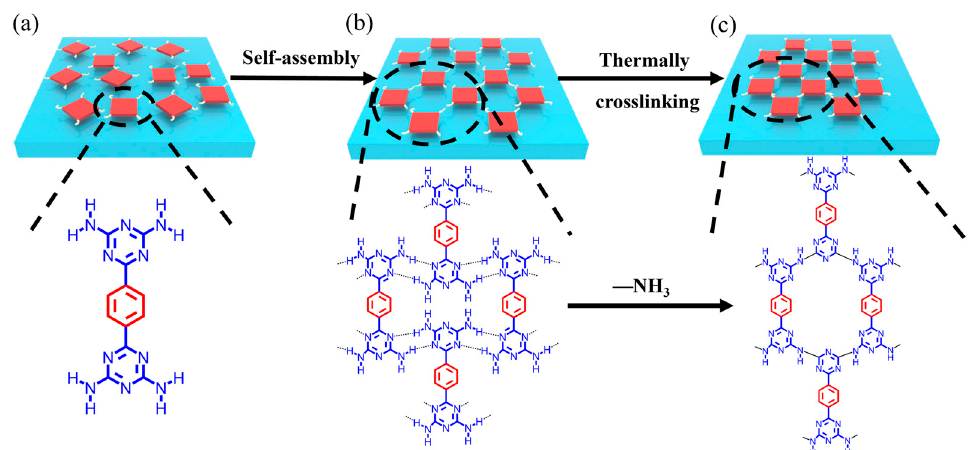
Figure 1. Schematic diagram of ( a ) self-assembly of BDAT monomer from solvent to generate ( b ) FDU-HOF-1, and ( c ) thermally crosslinked HOF (in the molecular formula: red, phenyl units and blue, DAT units..